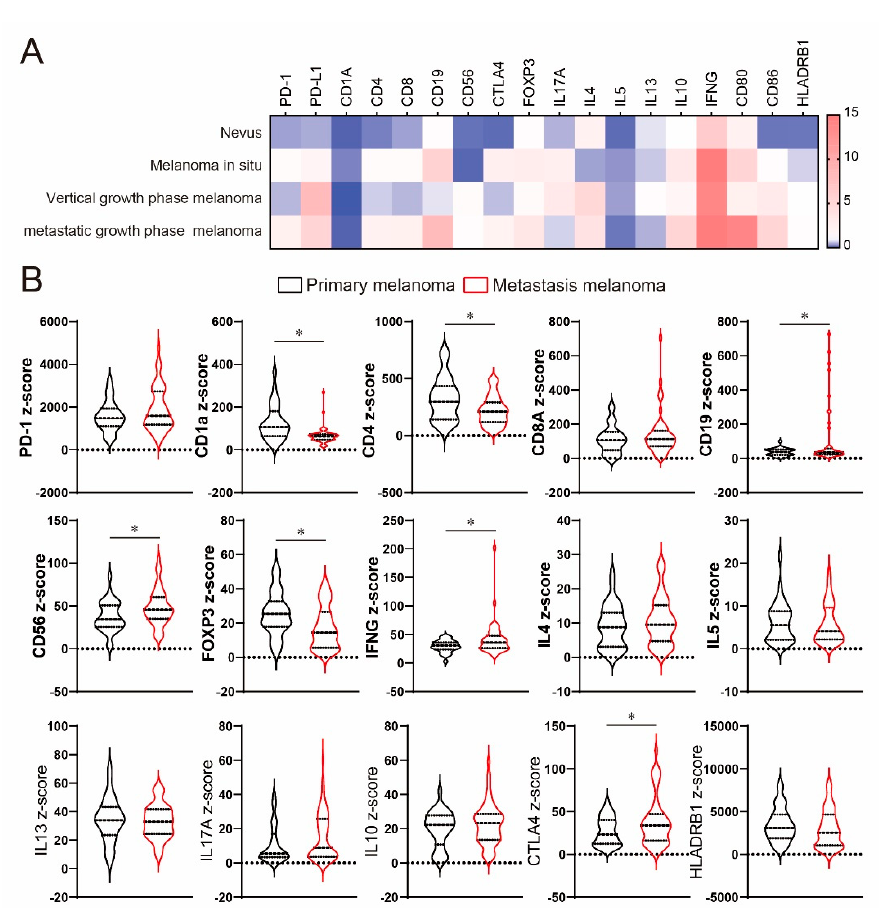
Figure 3. Gene expression in the tumor in patients with melanoma. ( A ) Heatmap representing relative gene expression compared with healthy skin. ( B ) Violin plots showing the differences in gene expression in primary melanoma and metastatic melanoma. All p -values were obtained by Student’s t test: *, p < 0.05.